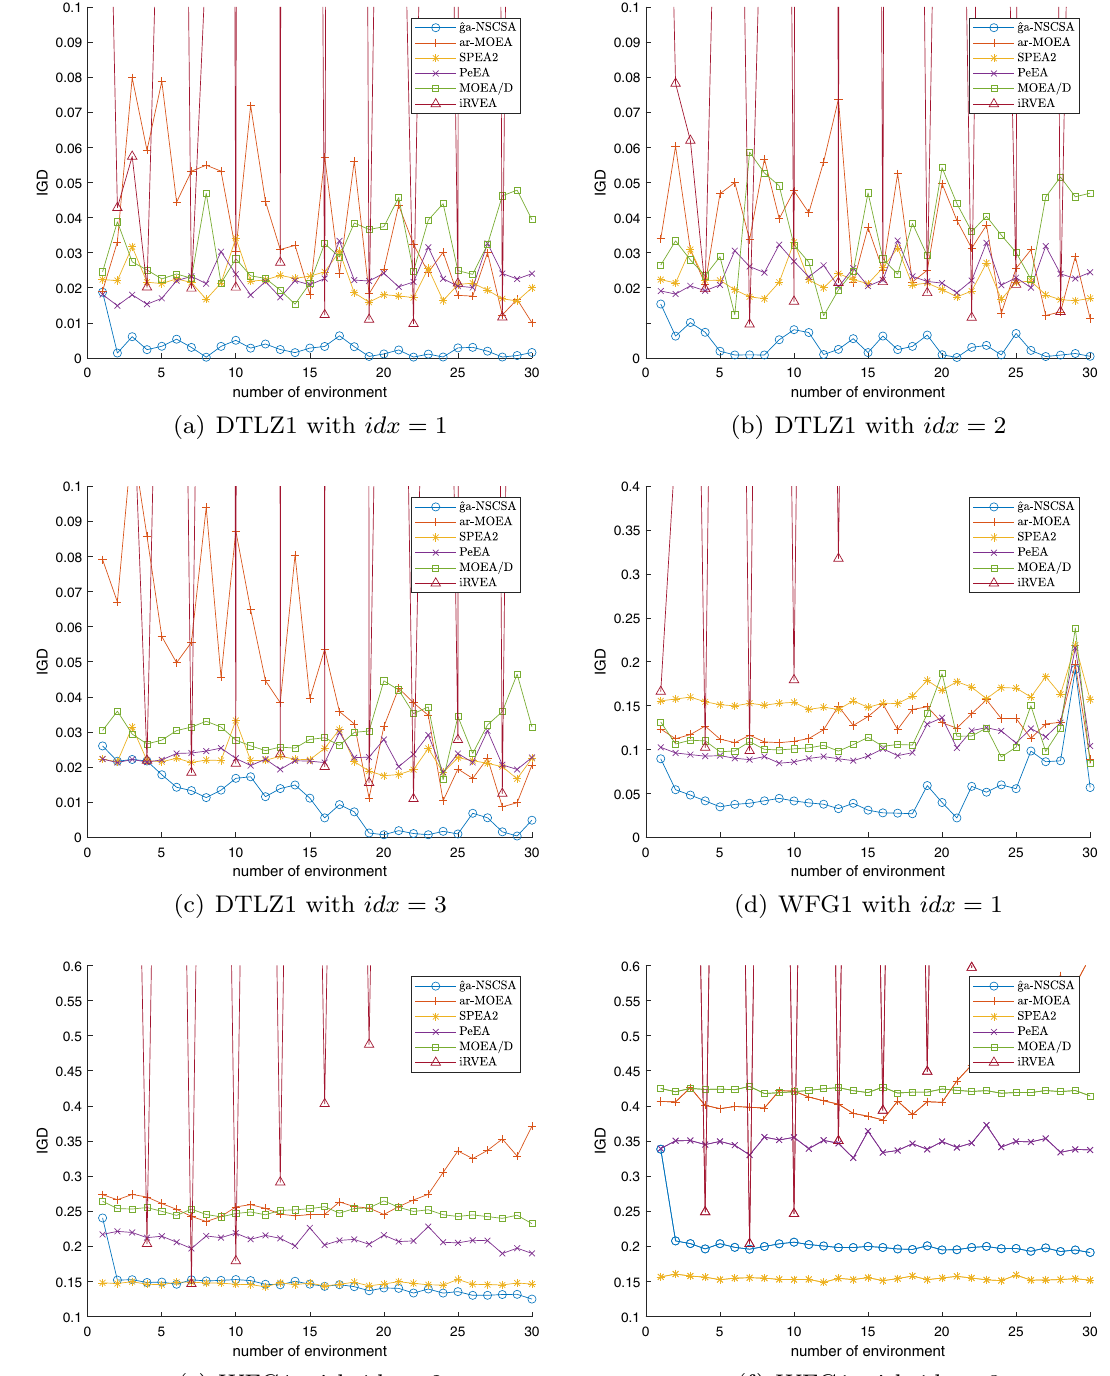
Fig. 7 IGD values in different environments of various problems and initial reference